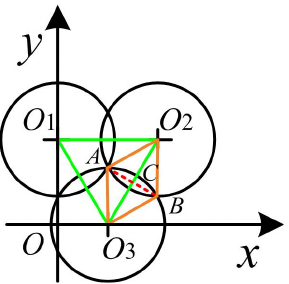
Figure 3. Node coverage